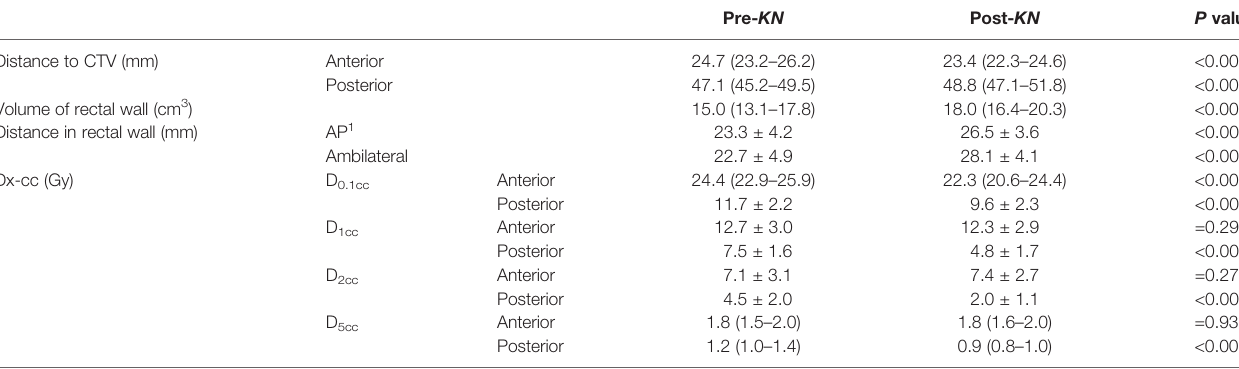
TABLE 3 | Rectum geometric changes and dosimetric comparisons.